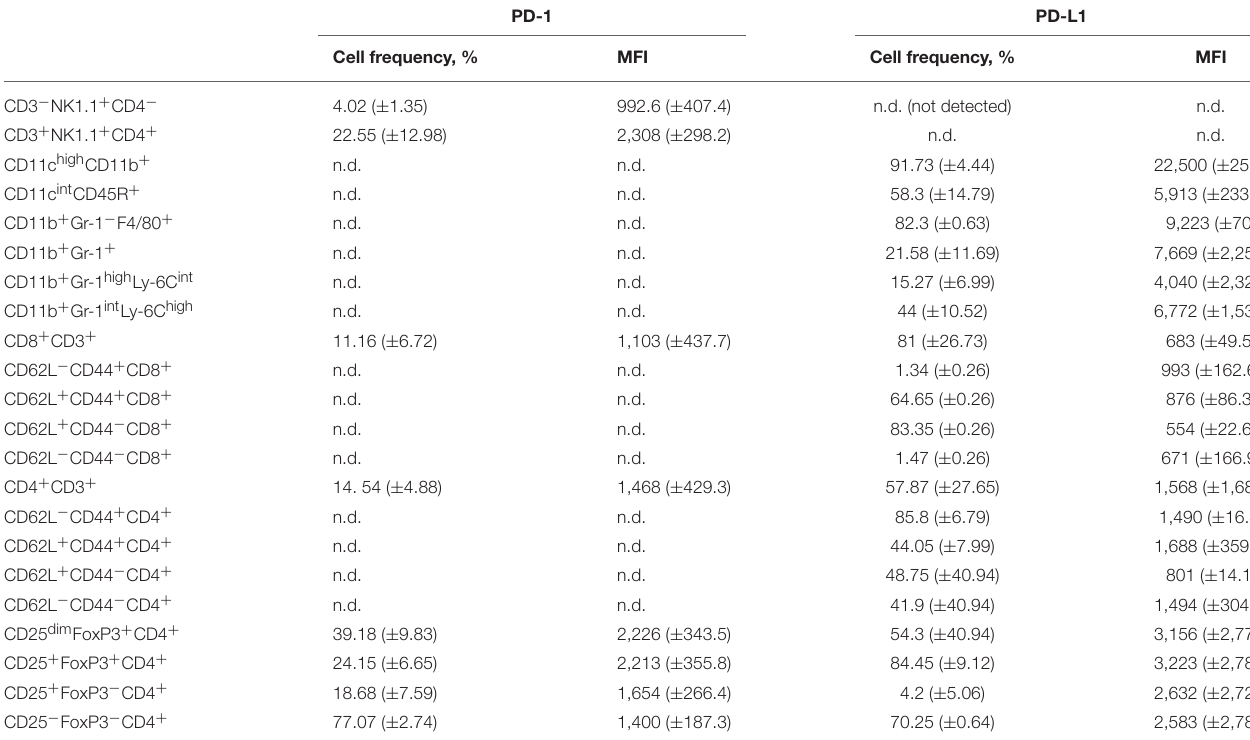
TABLE 1 | Distribution of PD-1 and PD-L1 expression on immune cell